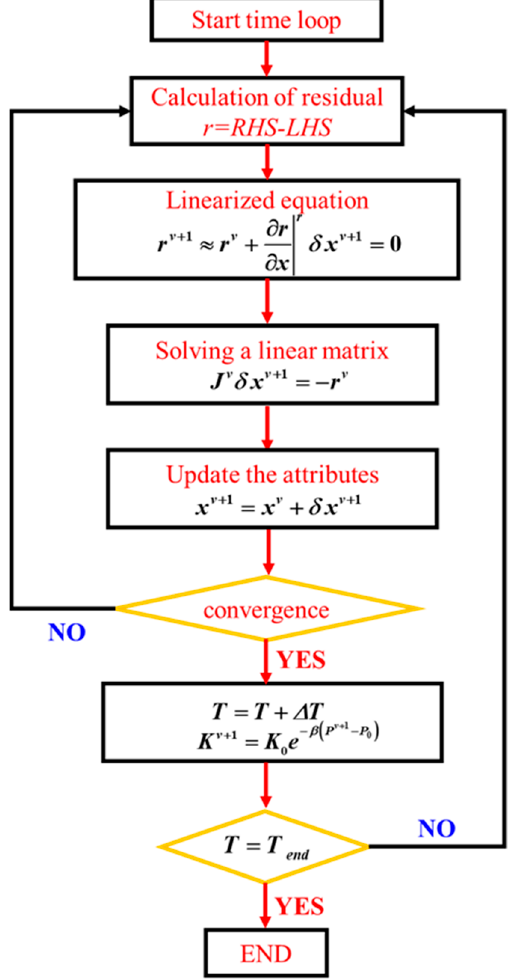
Figure 3. Numerical simulation process of embedded discrete-fracture model.